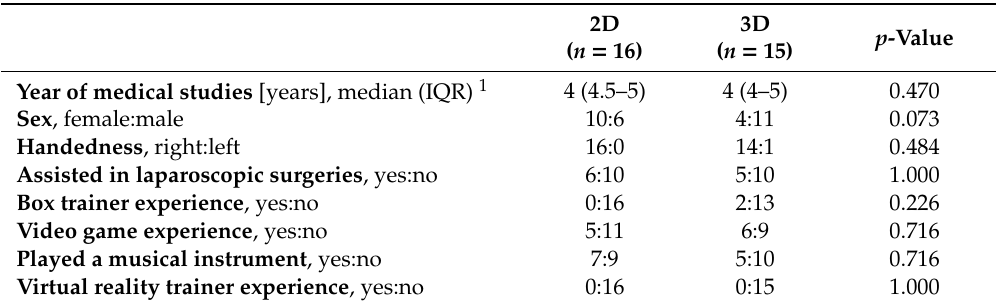
Table 1. Baseline demographic data of participants in the two-dimensional (2D) and three-dimensional (3D) groups.